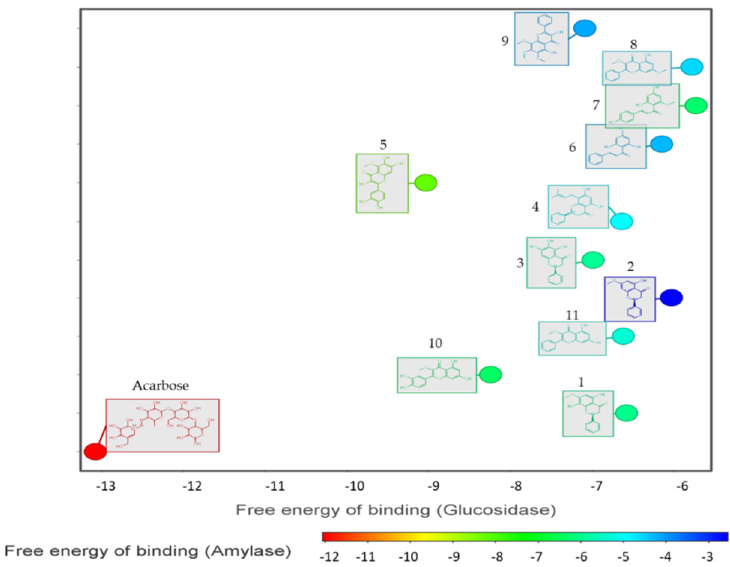
Figure 3. The free binding energy of compounds 1 – 11 and acarbose to the active sites of alpha- glucosidase and amylase.